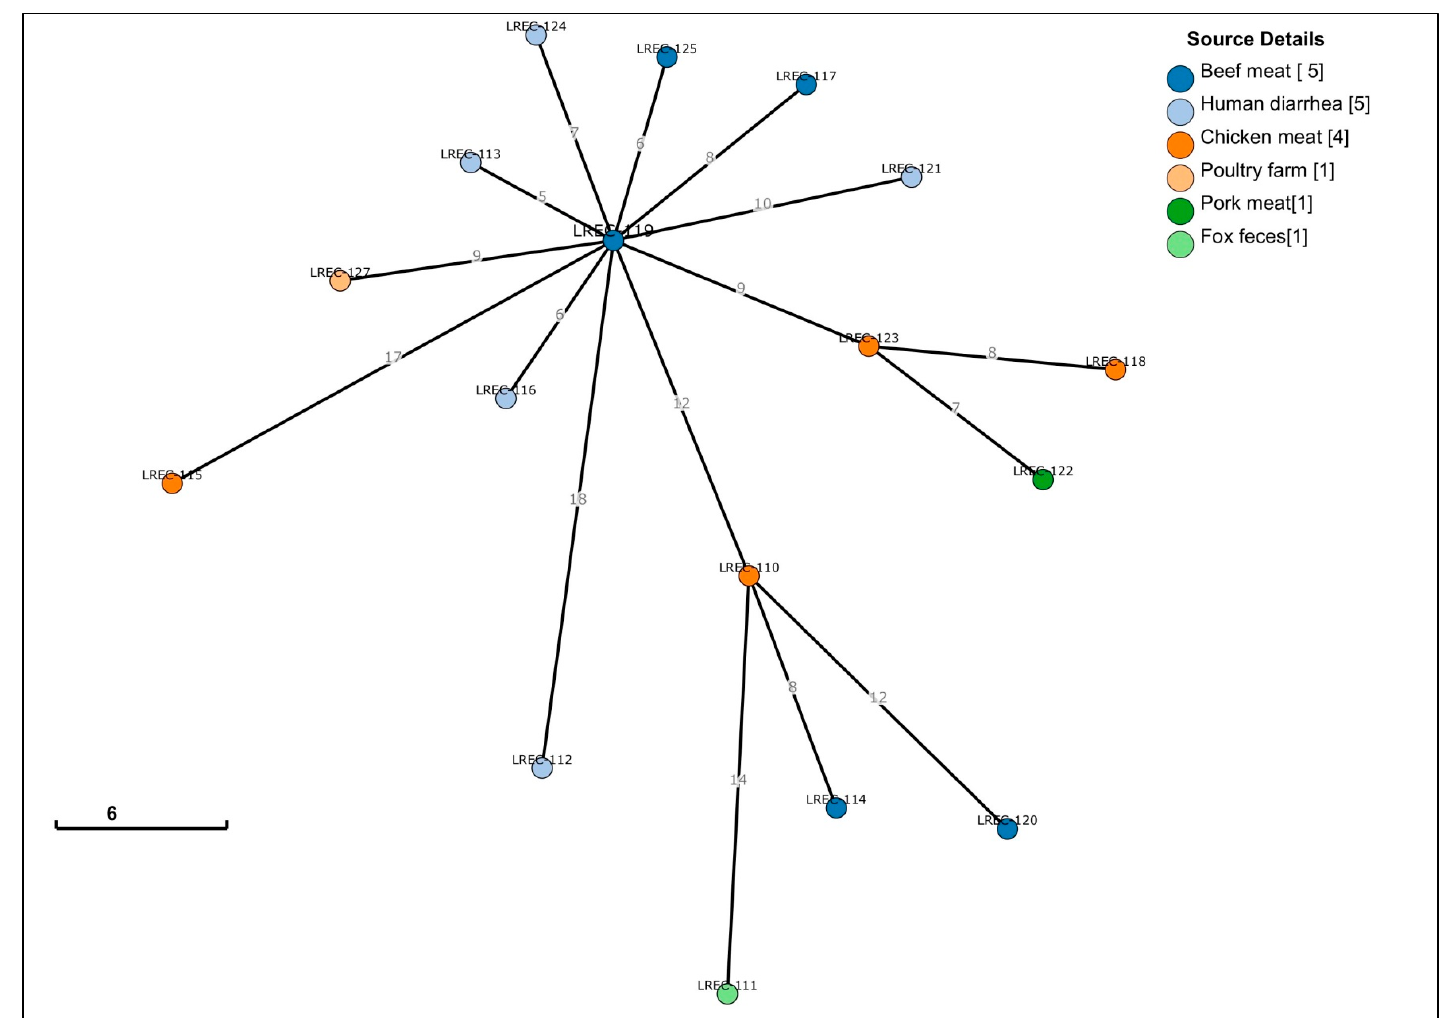
Figure 2. GrapeTree inferred using the MSTree V2 algorithm based on the cgMLST V1 + Hierarchical Clustering (HierCC) V1 scheme from EnteroBase.